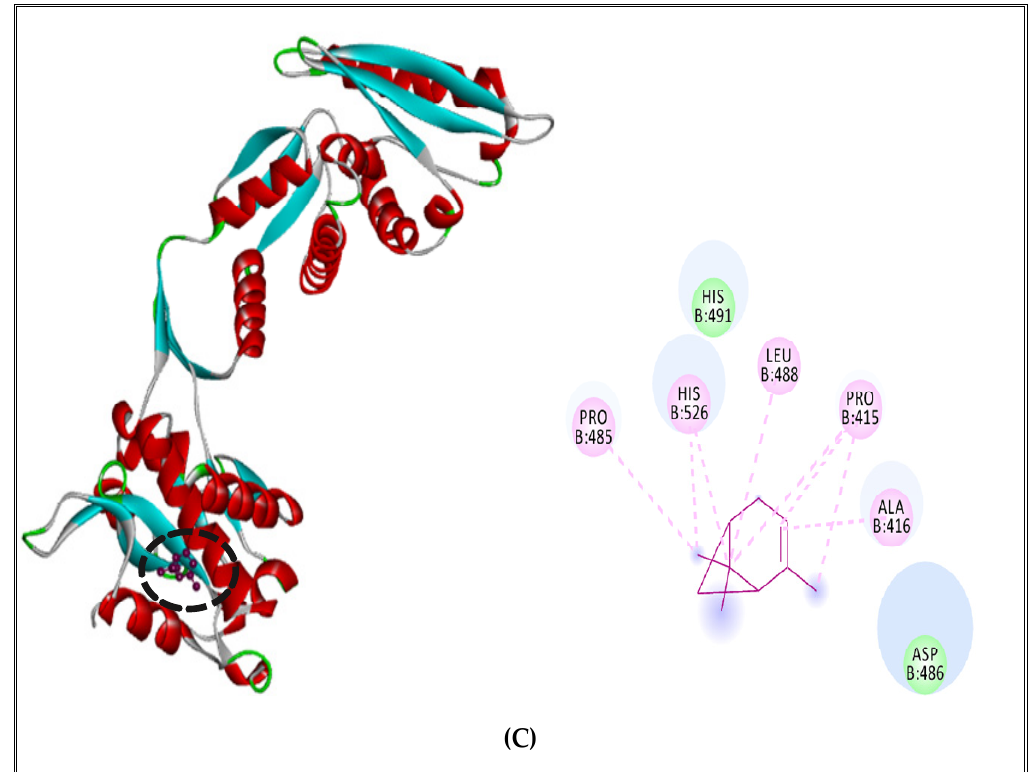
Figure 5. α -Pinene complexed with DNA polymerase enzyme ( A ), RNA polymerase ( B ), topoiso- merase II ( C ) of S. enterica Typhimurium.